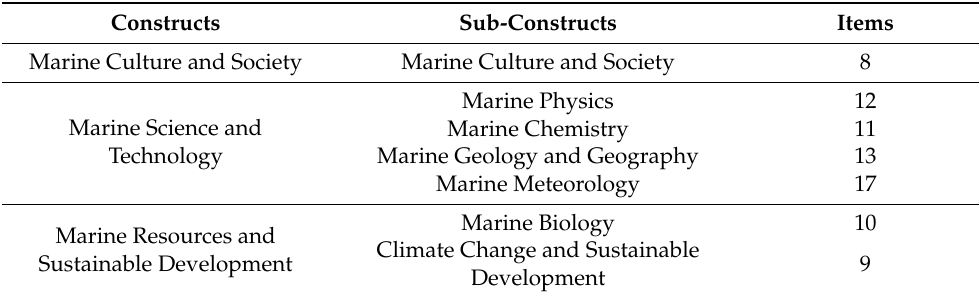
Table 2. Item distribution in accordance with components of the marine education curriculum of Taiwan. Constructs Sub-Constructs Items Marine Culture and Society Marine Culture and Society 8 Marine Physics 12 Marine Science and Marine Chemistry 11 Technology Marine Geology and Geography 13 Marine Meteorology 17 Marine Biology 10 Marine Resources and Climate Change and Sustainable Sustainable Development Development